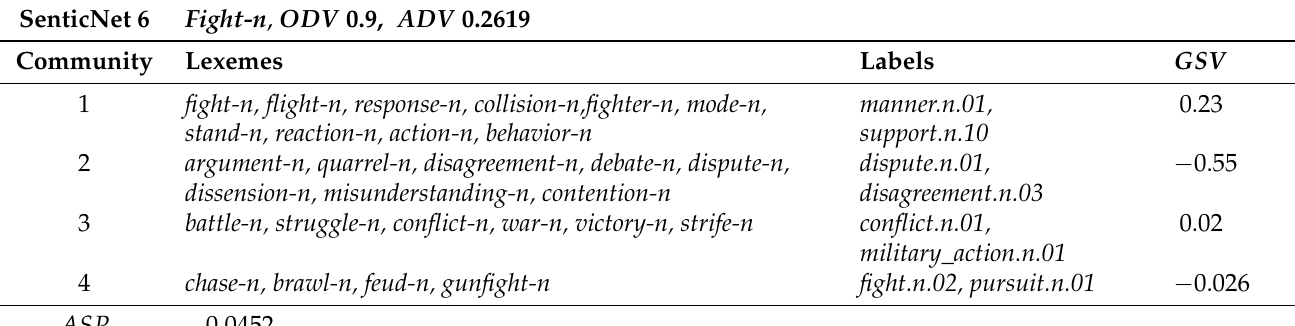
Table 8. Sentiment potential (SP): Labels and propagated GSV of lexical communities for seed lexeme fight-n calculated with SenticNet 6 polarity_value on ententen13